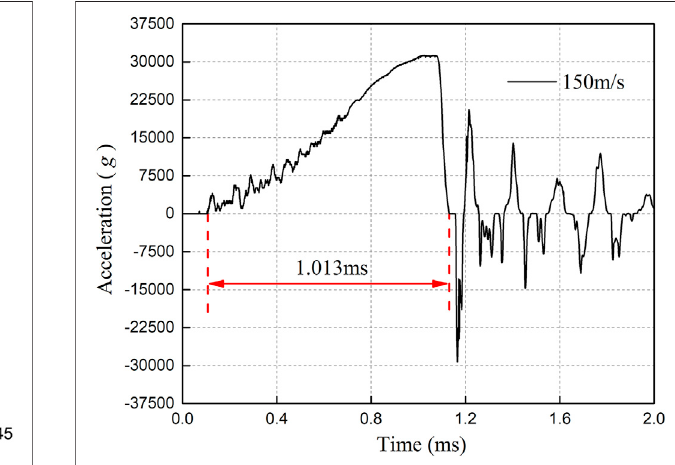
FIGURE 2 | True stress-strain curve of 3A21 alloy.